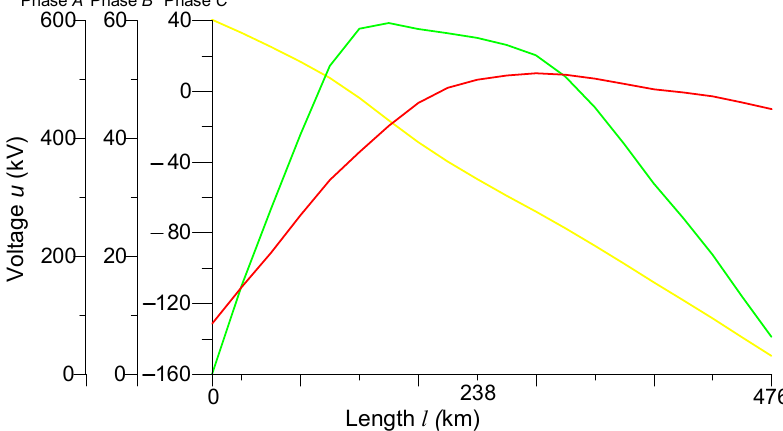
Figure 7. Temporal-spatial current distribution of phase B in line at the time t